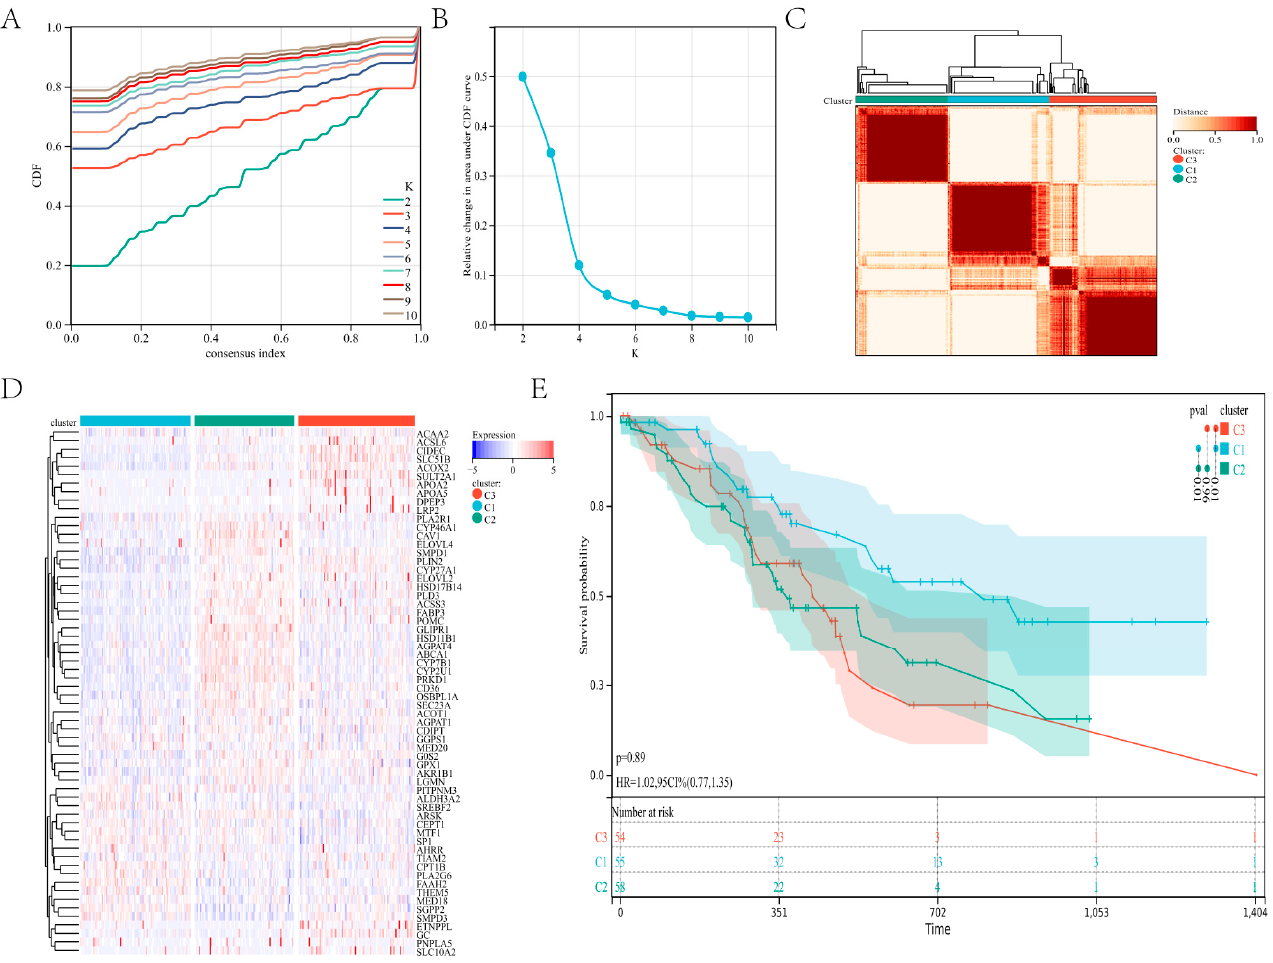
Figure 2. Consensus clustering: ( A – C ) The consensus cluster, K = 3, was determined to be the optimal value. ( D ) The heatmap in the three subtypes. ( E ) Survival curves for the three subtypes of patients.